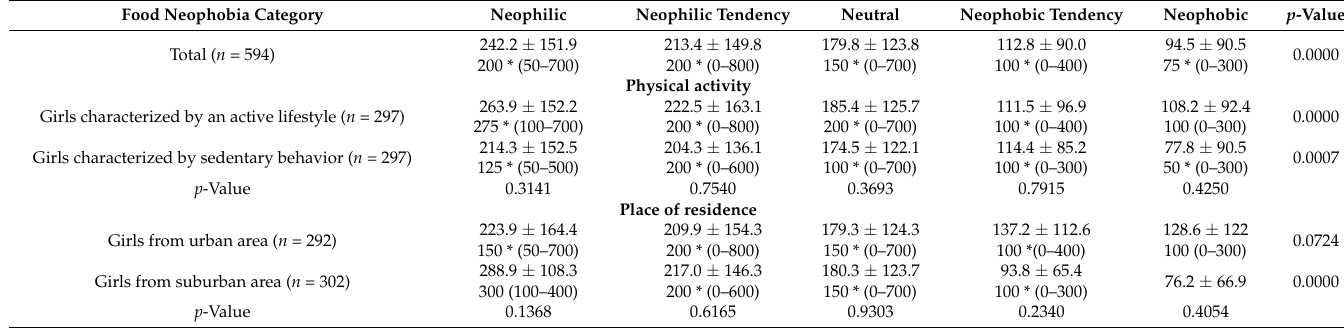
Table 2. Vegetable intake (g/day) for girls in Food Neophobia Scale categories—mean ± SD, as well as median, minimum, and maximum values are presented for food neophobia categories and compared between subgroups characterized by an active lifestyle ( n = 297) and by sedentary behavior ( n = 297), as well as from urban area ( n = 292) and suburban area ( n = 302).